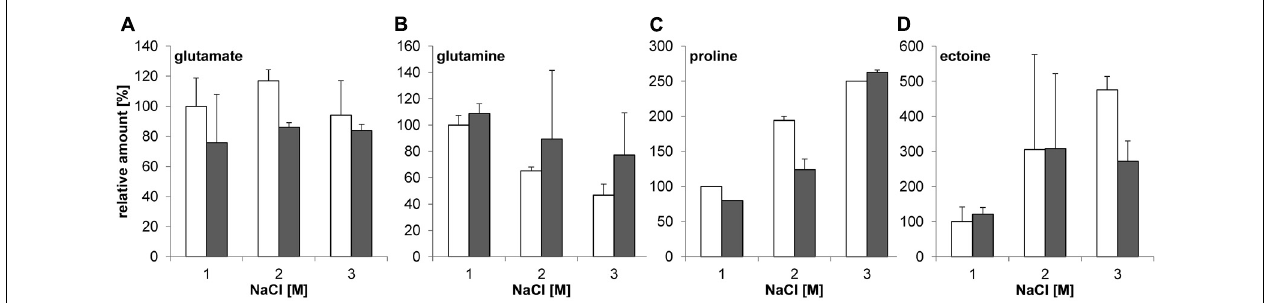
(white) and (cid:2) glnA2 mutant (gray) by HPLC.The presented relative quantification of solutes was conducted using the value of “wild type, 1.0 M NaCl” sample as a reference.The values represent the means and the standard deviations of the mean (S.D.s) of at least two physiologically independent